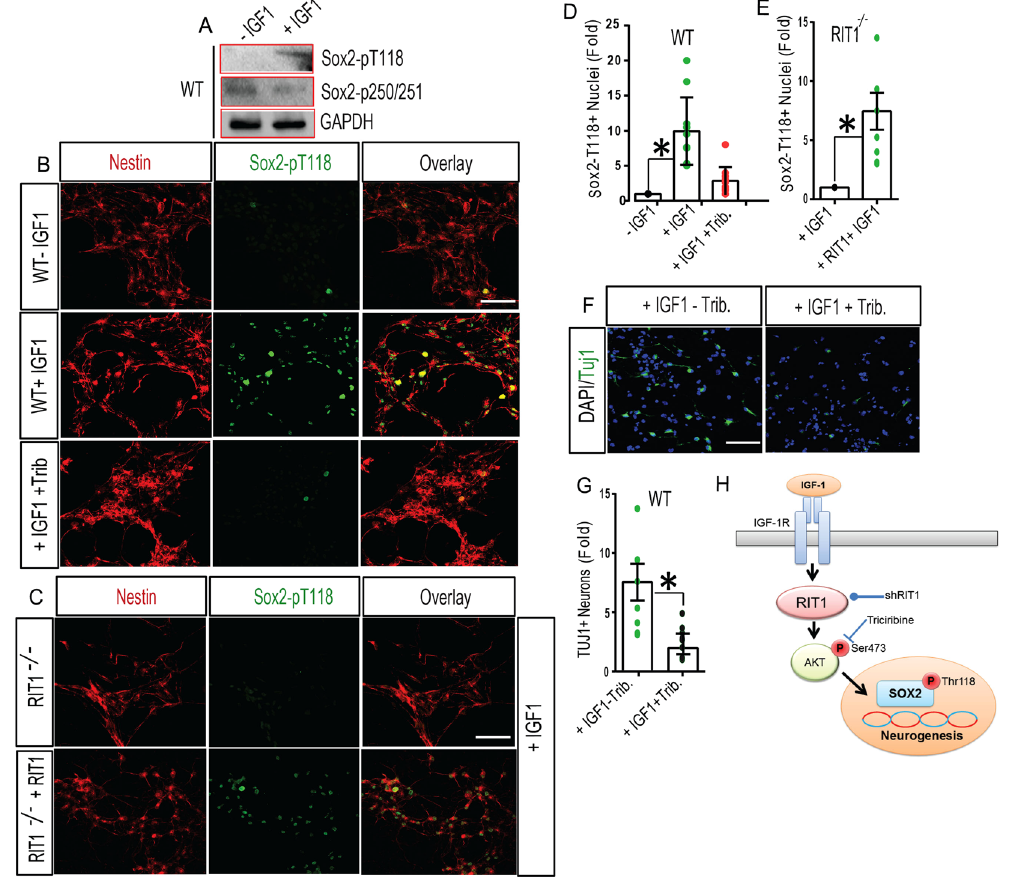
Figure 8. IGF-1-dependent Sox2 phosphorylation relies on RIT1 -Akt signaling. ( A ) Immunoblotting for levels of Sox2 phospho-Ser250/Ser251 and SOX2 phospho-T118 with and without IGF-1 stimulation (50 ng/ml; 24 h). Representative images were cropped from the original blots run in parallel. ( B , C ) Representative confocal images of phospho-Sox2 T118 + nuclei in WT, RIT1 − / − , or RIT1 − / − HNPCs complemented by re-expression of Myc-RIT1 left untreated (-IGF-1) or 24 h after stimulation with IGF-1 (50 ng/ml) or co-stimulated with IGF-1 and the Akt inhibitor Triciribine (3 µ M Trib.) and immunostained for phospho-Sox2 T118 ( green ) and Nestin ( red ). Scale bar, 20 μ m. ( D , E ) Quantification of Nestin + /Sox2 T118 + cells following IGF-1 stimulation of WT HNPCs with or without Akt inhibition (1–4 uM Trib.) ( * p < 0.05, one-way ANOVA) or IGF-1 stimulation of RIT1 − / − HNPCs with or without RIT1 complementation ( * p < 0.05, nonparametric one tailed t-test) ( ≥ 200 cells counted from 5–6 fields). ( F ) Representative confocal images of HNPCs co-immunostained for Tuj1 + ( green ) and DAPI (nuclei, blue ) following IGF-1 (50 ng/ml) stimulation with or without Akt inhibition (1–4 uM Trib.). ( G ) Quantification of Tuj1 + neurons in WT HNPCs following IGF-1 stimulation (50 ng/ml) ± Triciribine (3 μ M) ( ≥ 500 cells from 5–6 fields) ( * p < 0.05, nonparametric t-test). Data are presented as mean ± SEM calculated from three separate experiments. ( H ) Schematic diagram of the putative IGF-1/RIT1/Akt/Sox2 signal transduction cascade. The sites of pharmacological inhibition ( ⊥ ) and the target of shRNA silencing reagents ( • ) are